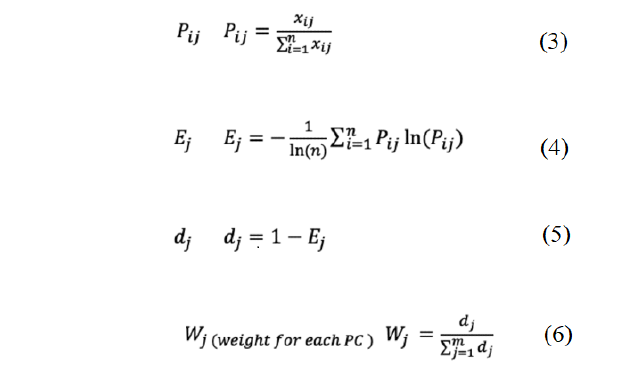
Table 3. Kaiser–Meyer–Olkin (KMO) analysis (Cronbach alpha values) of the three domains of the China Hospital Development Index.